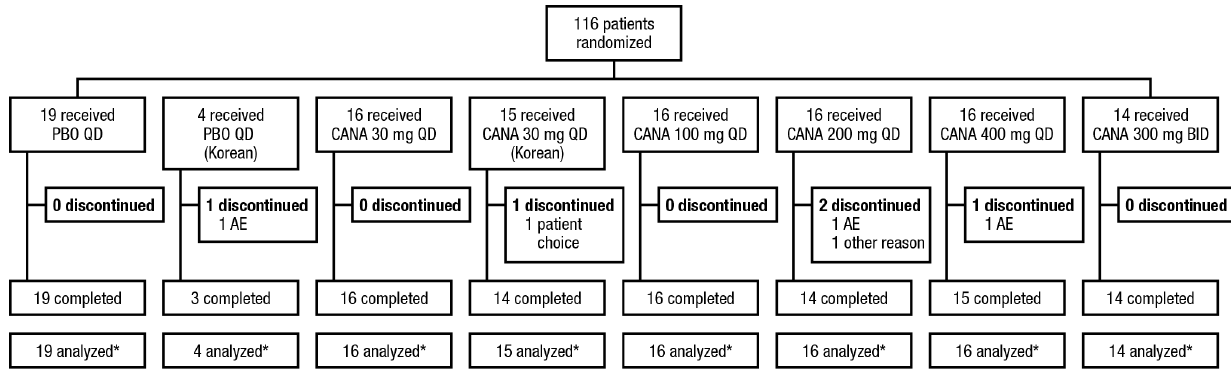
Figure 1. Study flow diagram. PBO, placebo; QD, once daily; CANA, canagliflozin; BID, twice daily. *Safety analysis set.